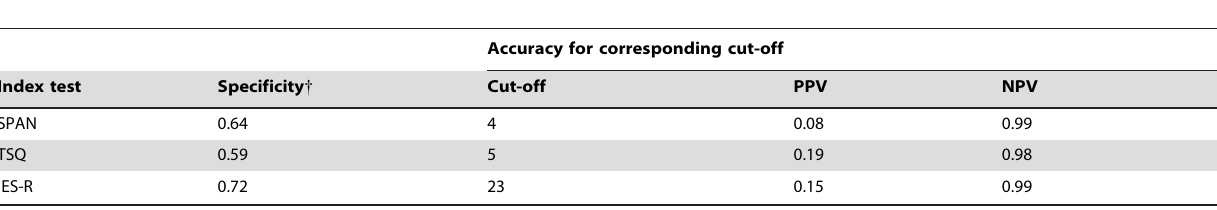
Table 2. Specificity values of the SPAN, the TSQ and the IES-R at 80% sensitivity, and corresponding cut-off values, PPVs and NPVs.